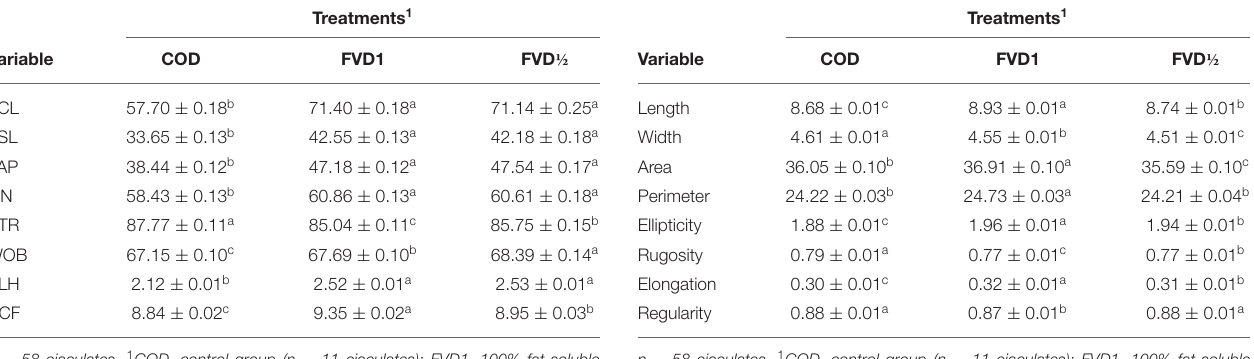
TABLE 6 | Morphometric variables (mean ± SEM) of size and head shape of boar TABLE 5 | Effect of dietary fat-soluble vitamin supplementation on kinematic sperm in different treatments with fat-soluble vitamin sperm variables (mean ± SEM) of boar ejaculates. Treatments 1